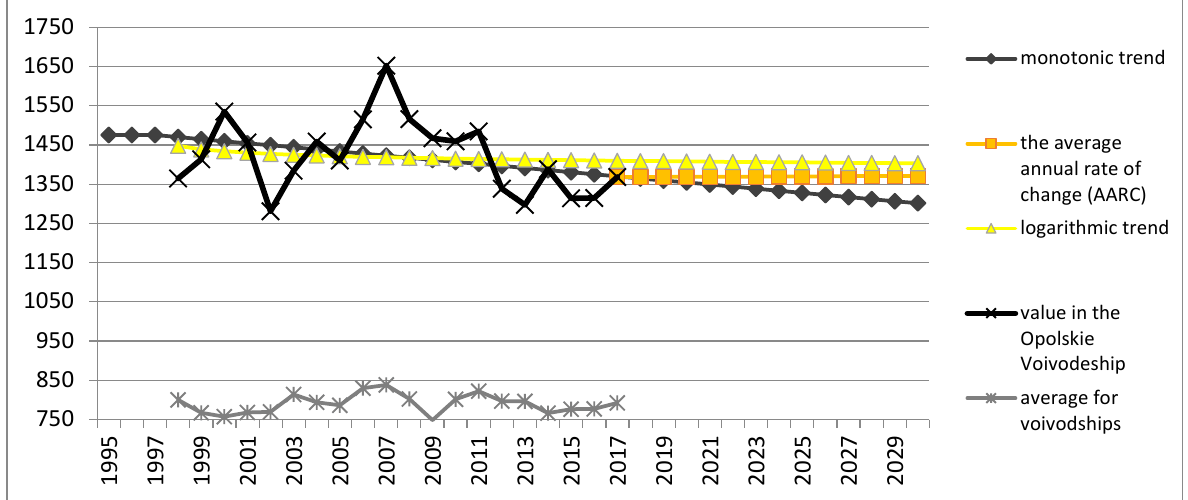
Figure 4. Gas pollutant emission from particularly troublesome plants, including CO 2 emission per km 2 of surface area (in tons per year per km 2 of surface area). Source: own elaboration. As a result of the impact of the aforementioned determinants, the lack of air quality improvement in relation to the PM10 content was maintained, i.e., the average daily